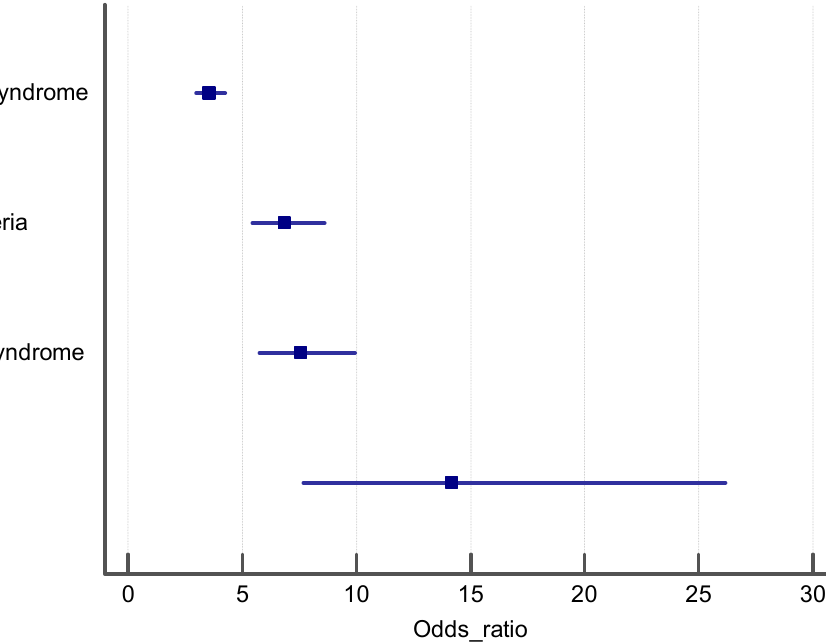
Figure 3. The estimated odds ratio for the association of anxiety and FD in each control group.